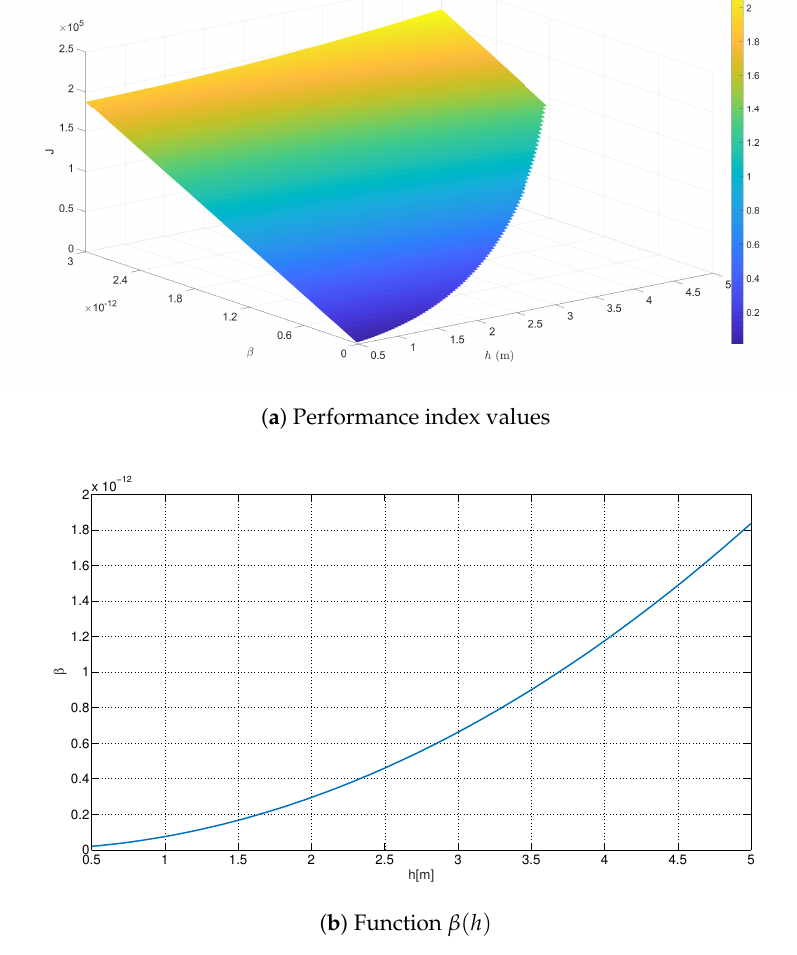
Figure 5. β values as a function of an altitude h